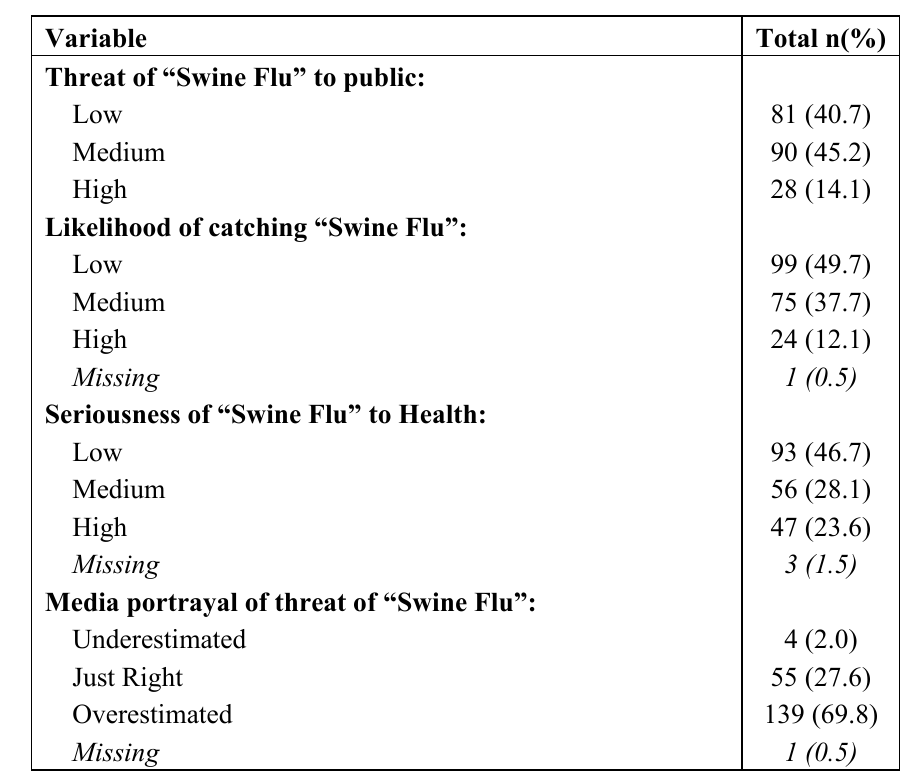
Table 2. Respondents’ attitudes to Pandemic Influenza A (H1N1) 2009